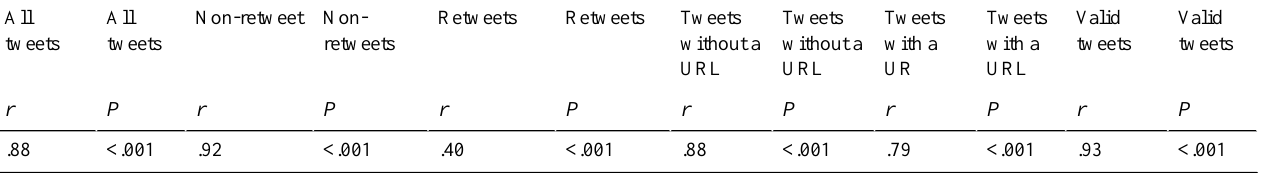
Table 6. Correlations between tweets and number of laboratory-confirmed influenza cases in San Diego. a